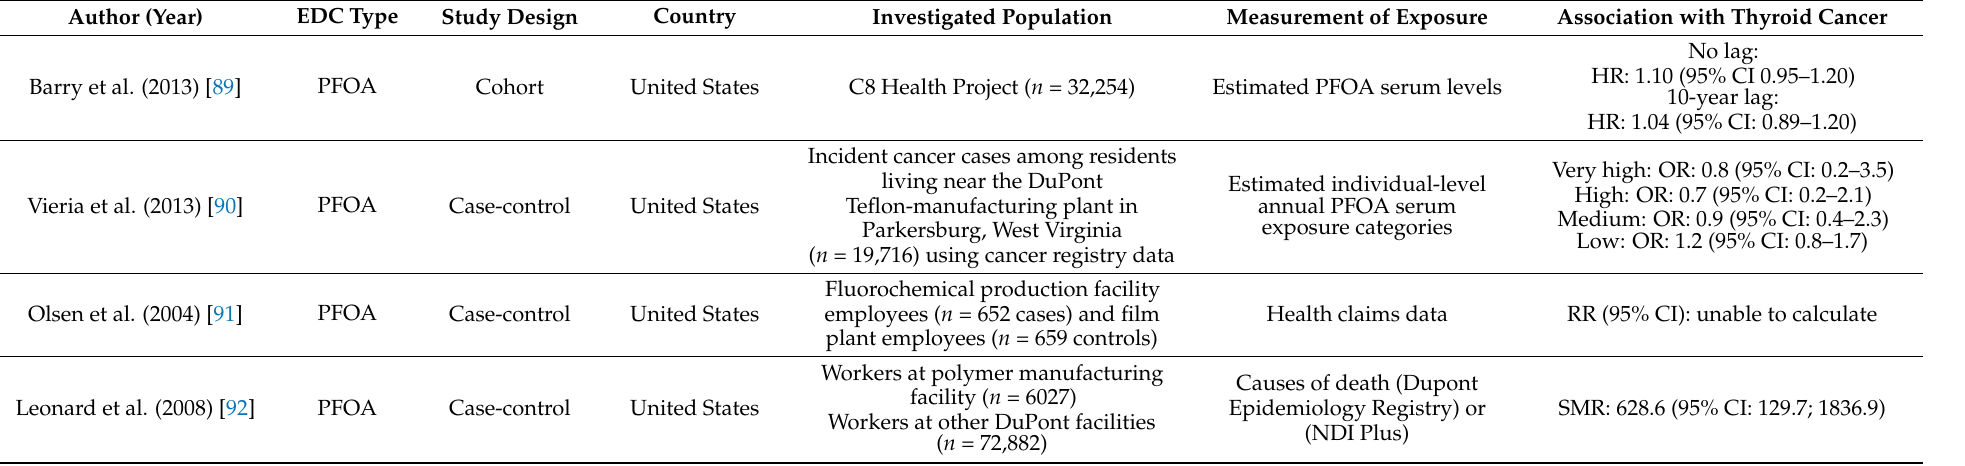
Table 5. Association between exposure to PFAS and thyroid cancer. Abbreviations: CI: confidence interval; EDC: endocrine disrupting chemicals; HR: hazard ratio; NDI: national death index; OR: odds ratio; PFOA: perfluorooctanoic acid; RR: risk ratio; SMR: standardized mortality